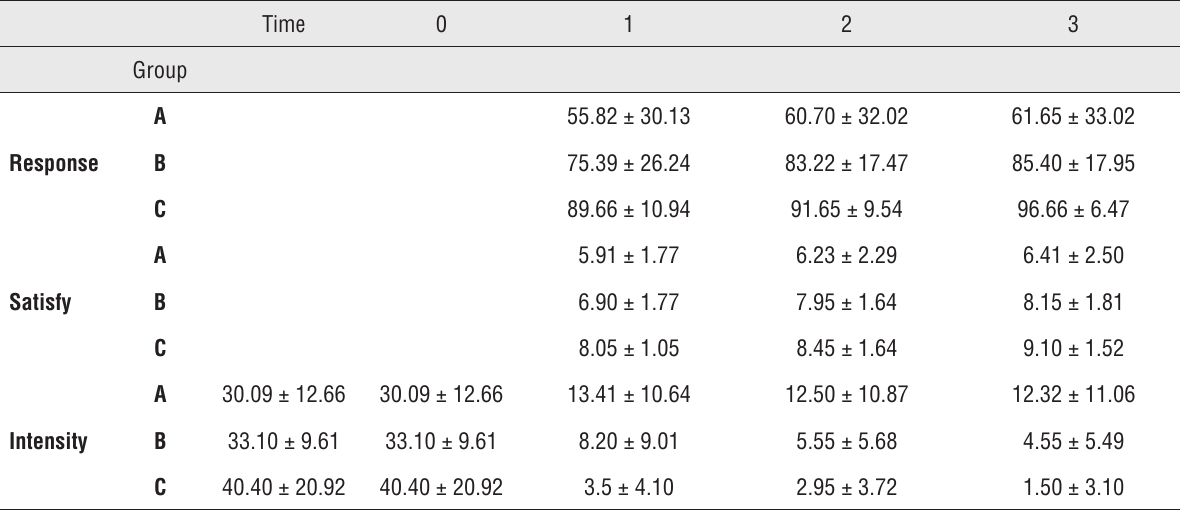
Table 2 - Response, Satisfy and Intensity during the periods of